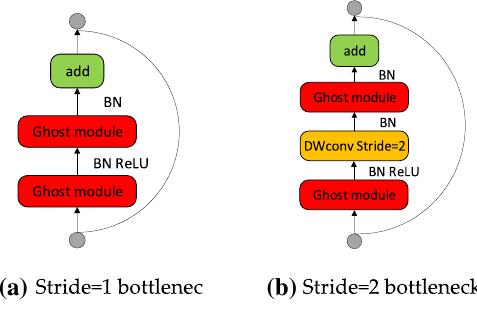
Figure 5. Ghost bottleneck.